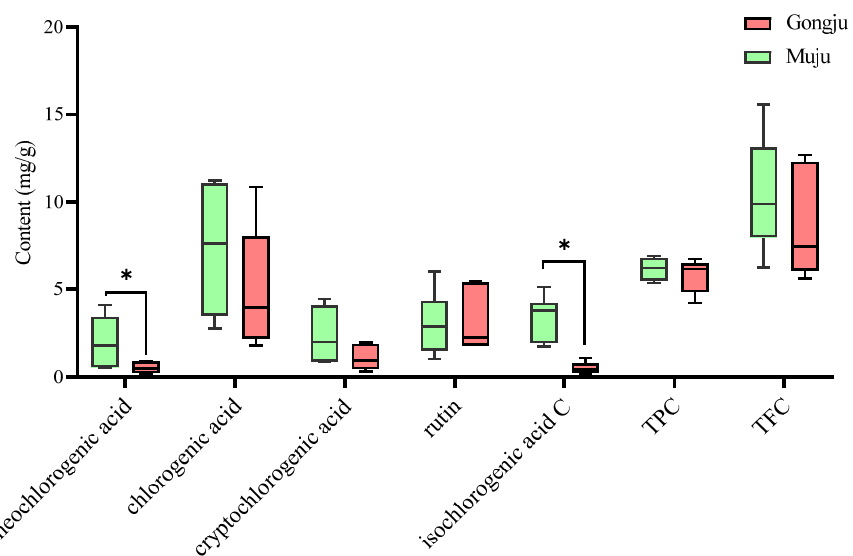
Figure 2. Boxplot analysis of marker compounds in 14 batches sample from Gongju and Muju. TPC: total phenolic content; TFC: total flavonoid content. * p < 0.05.